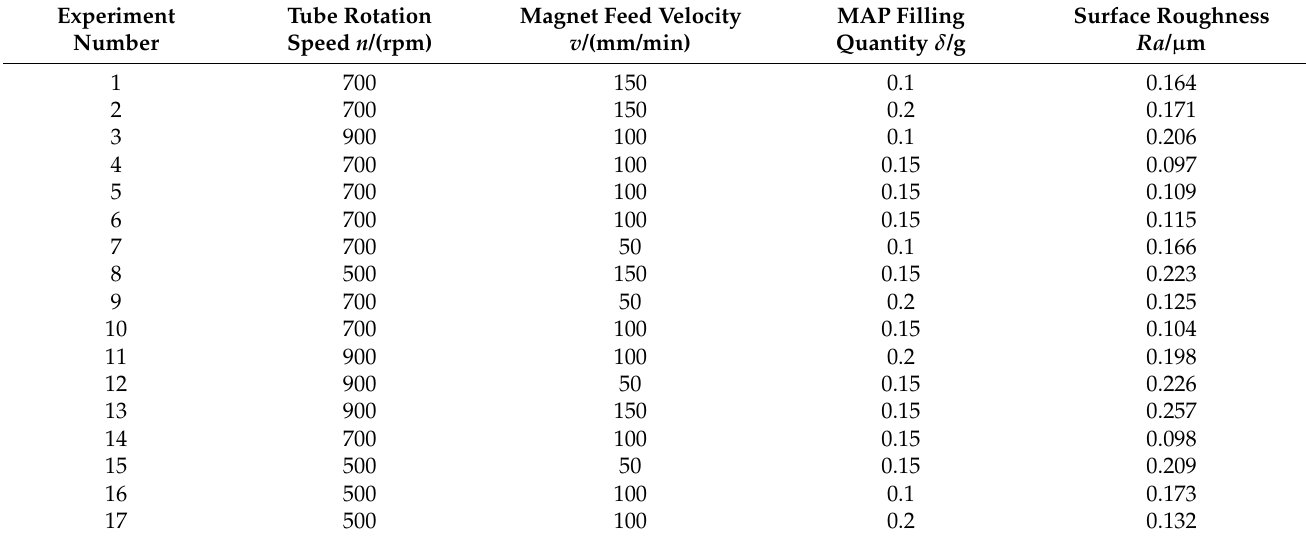
Table 5. Test plan and results.